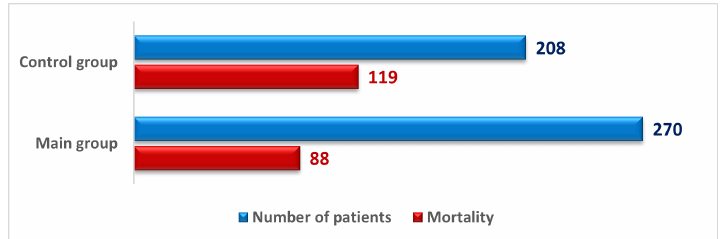
Figure 6. Mortality in the study and control